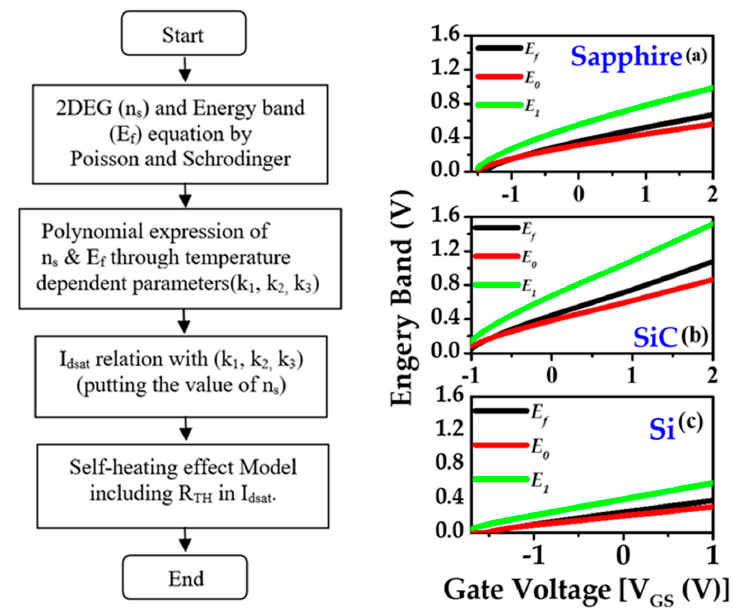
Figure 7. Charge control model flowchart of the self-heating effect and energy bands of sapphire ( a ), SiC ( b ), and Si ( c ). Current-Voltage Characteristics